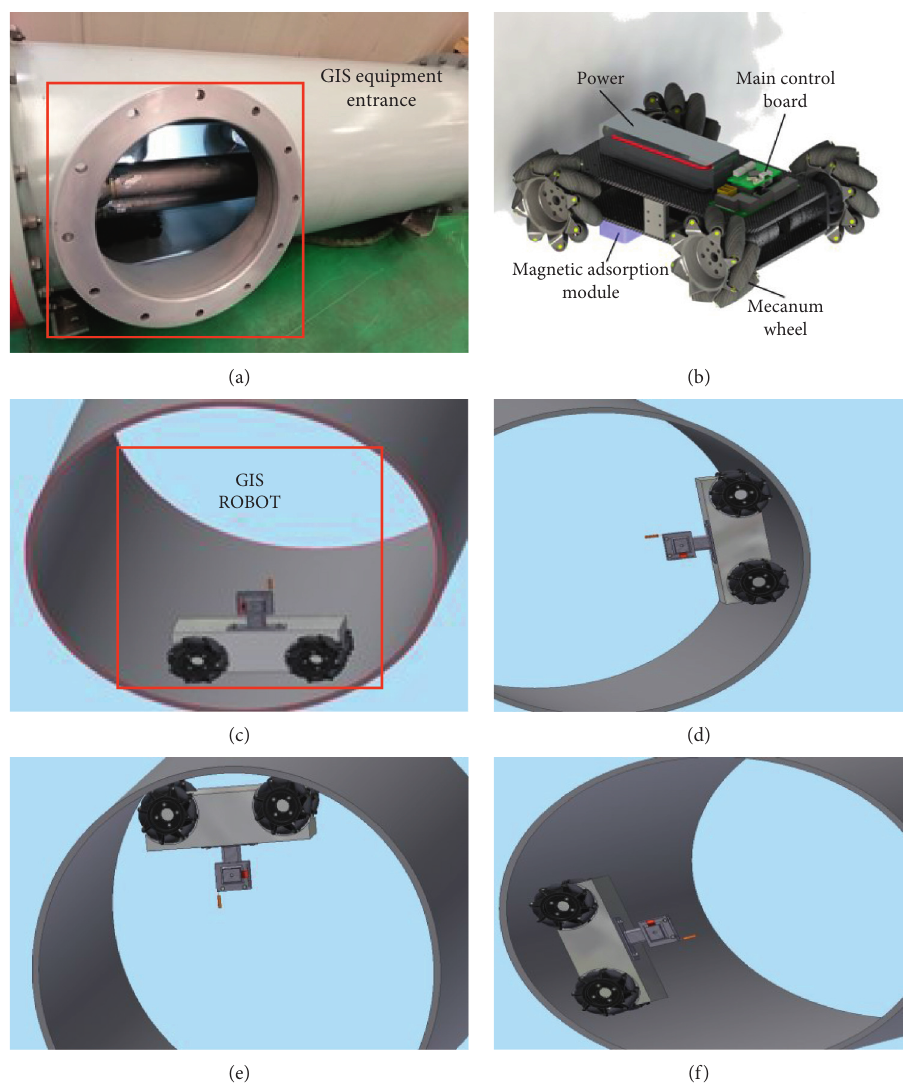
Figure 1: GIS equipment inspection robot with adsorption climbing function. (a) GIS operation environment, (b) robot three-dimensional structure, (c) robot inspection status-1 (initial state), (d) robot inspection status-2 (uphill slope), (e) robot inspection status-3 (apical adsorption), and (f) robot inspection status-4 (downhill slope).